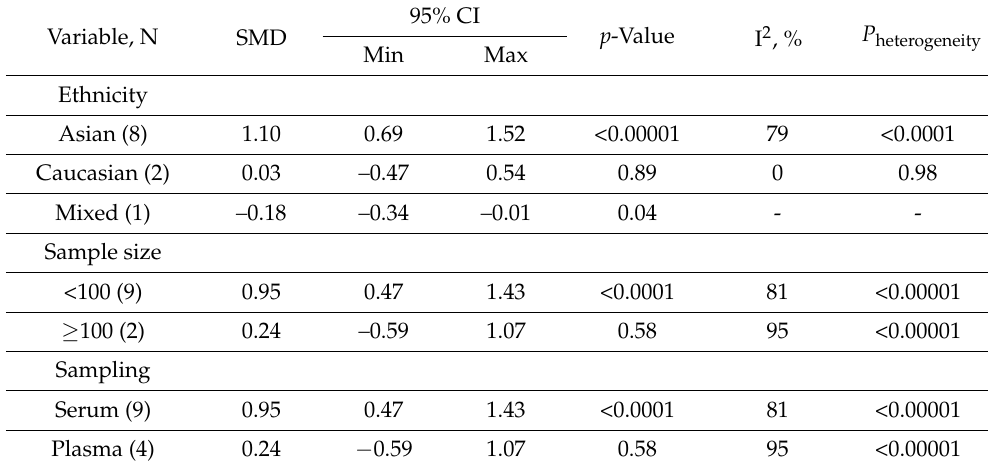
Table 2. Subgroup analysis in adults with obstructive sleep apnea compared to controls.